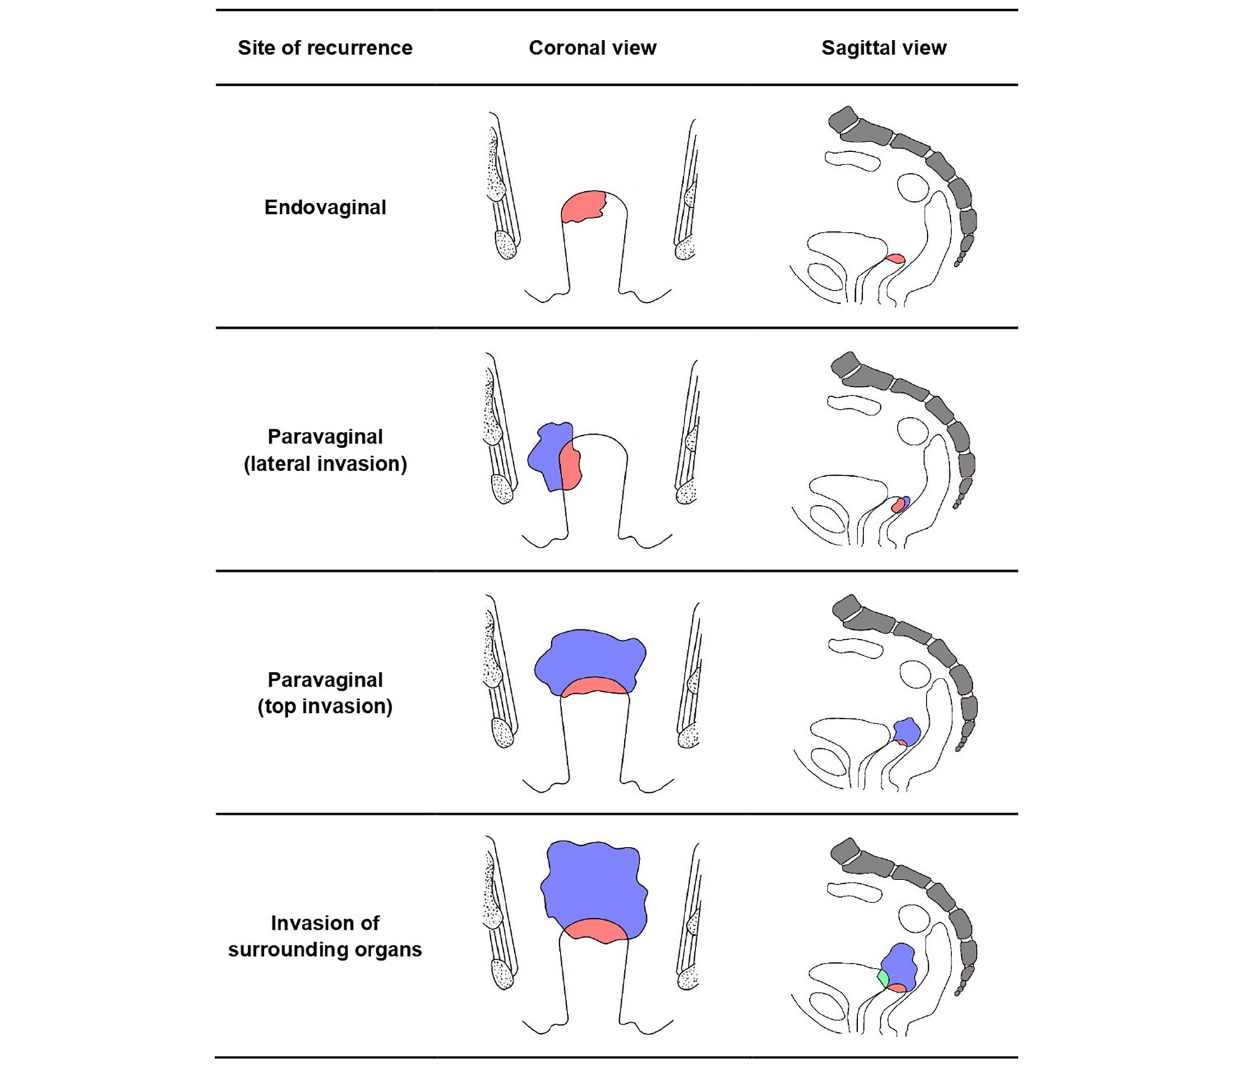
FIGURE 1 | Schematic diagram of recurrence